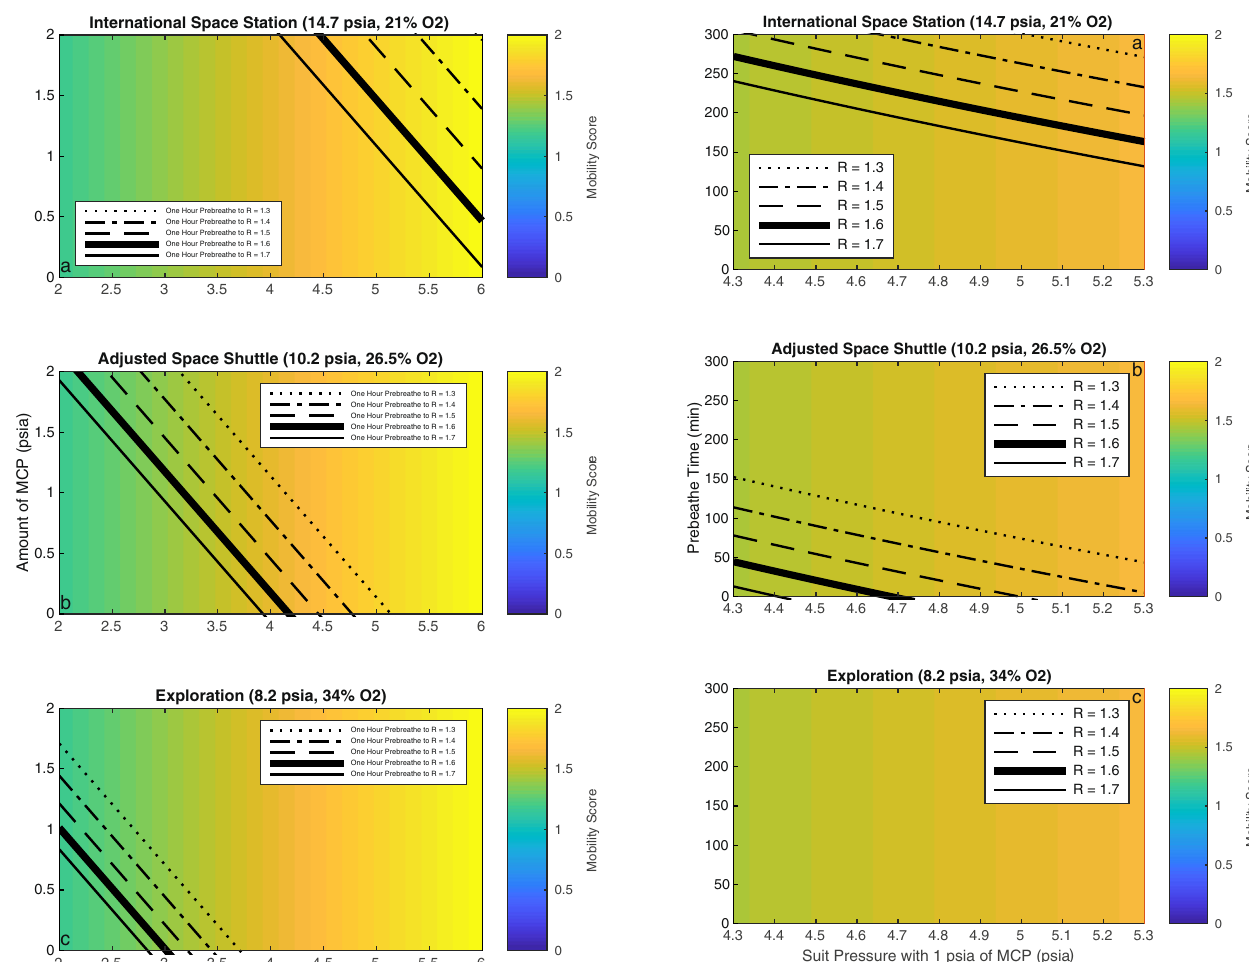
Fig. 4 Trade-off between spacesuit pressure (gas pressure plus 1 psia of MCP in x -axis), mobility score, and prebreathe time ( y - axis) to attain a given DCS risk value R between 1.7 (currently used in the ISS) and 1.3 (proposed in future planetary explora- tion) in ISS (top panel), adjusted Space Shuttle (middle panel), and exploration (bottom panel) atmospheric conditions. The mobility score is a function of gas spacesuit pressure only and it is independent to the amount of pressure provided as MCP. In ISS atmospheric conditions, additional MCP (thus increasing total spacesuit pressure) provides signi fi cant operational bene fi ts in reducing prebreathe times. Conversely, in exploration atmospheric conditions, additional MCP provides no bene fi ts with respect to prebreathing time, as none is necessary to reach an R = 1.3. Thus, in this case, it is more advantageous to use MCP to reduce gas pressure (maintaining a constant total pressure) to improve mobility